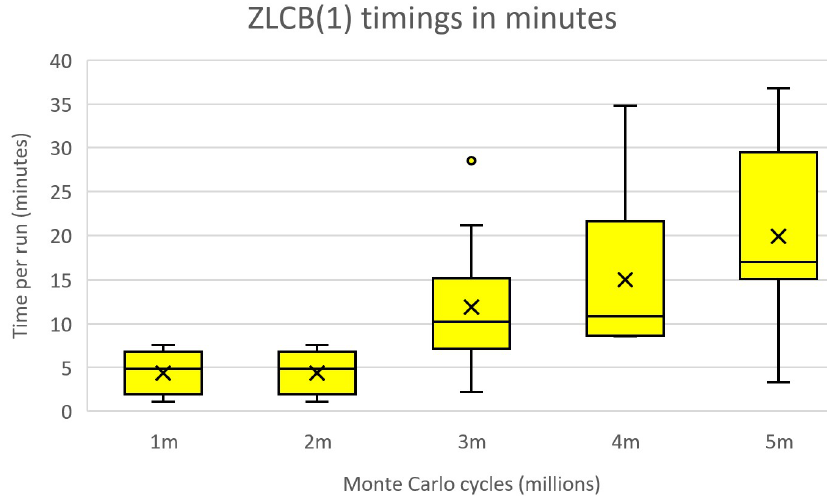
Figure 5. Box plot timings for ZLCB κ = 1 optimisation: 10 runs in each case